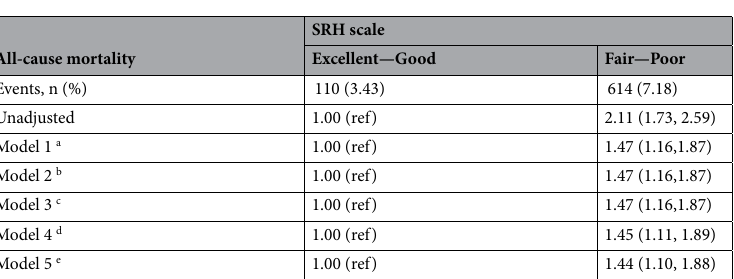
Table 2. Association of SRH with all-cause mortality risk. Values were presented as hazard ratios (95% confidence interval). SRH, self-rated health a Model 1: adjusted for age, sex, smoking status, drinking status, BMI, hypertension, Emotional, nervous, or psychiatric problems (ENP), dyslipidemia, diabetes, heart problems, cancer, chronic lung disease, memory-related disease, kidney disease, liver disease, arthritis, digestive disease and asthma, b Model 2: Model 1 + living place, c Model 3: Model 2 + education status, d Model 4: Model 3 + income level, e Model 5: Model 4 +